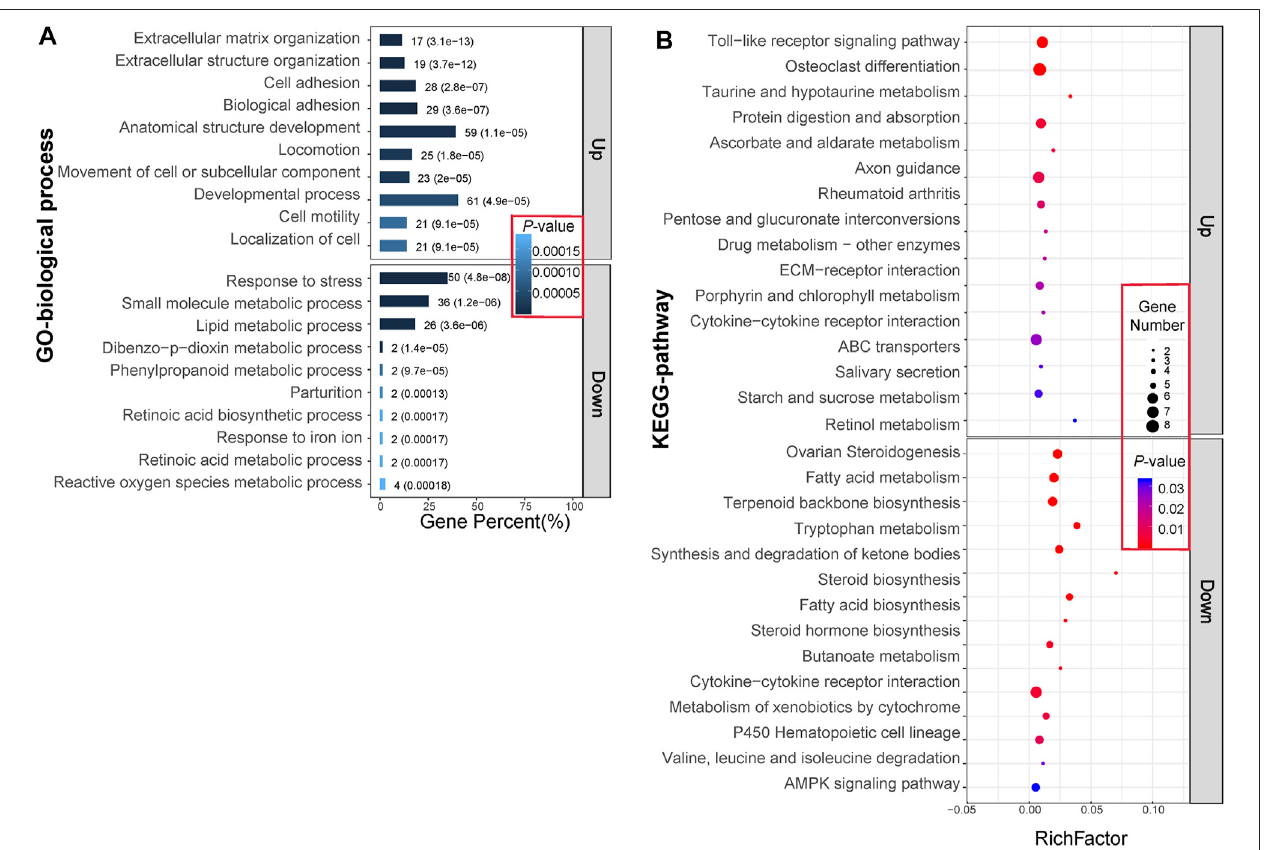
FIGURE3| GO (A) andKEGG (B) enrichmentanalysisof380differentiallyexpressedtranscripts(DETs). (A) Thebargraphsrepresentthetop10BPtermswiththe lowest p -value for upregulated and downregulated gene expression patterns. The numbers and parenthesis value on each bar graph separately represent the numbers of DETs enriched in it and the p -value. (B) The solid dots represent the top 15 KEGG pathways with the lowest p -values for upregulated and downregulated gene expression patterns. Different colored dots indicate the different p -value, while dots of different diameters represent the numbers ofDETs enriched. Abbreviations: Up, upregulation in IPF group; Down, downregulation in IPF